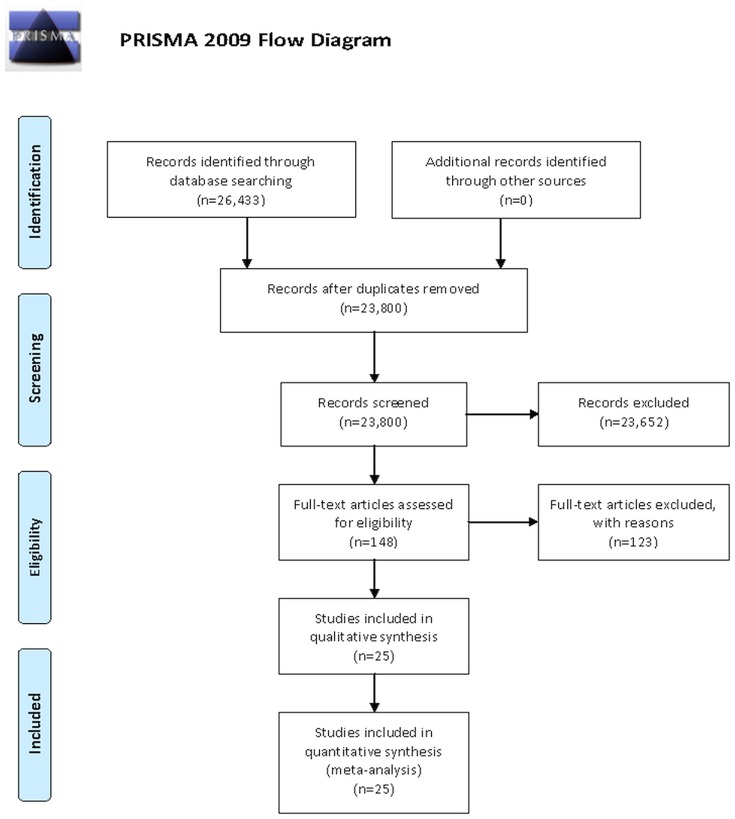
Flowchart of the process of search strategy adopted in the present meta-analysis.